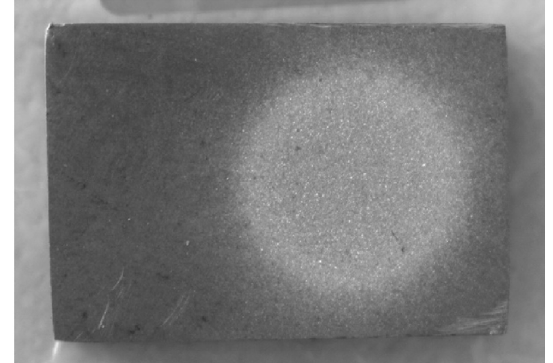
Fig. 6 Test sample and worn surface area.